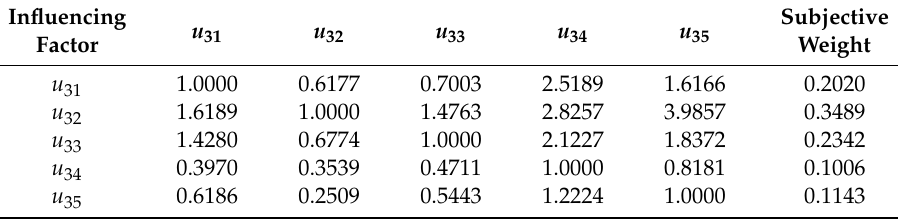
Table 17. The subjective weights of the switch influencing